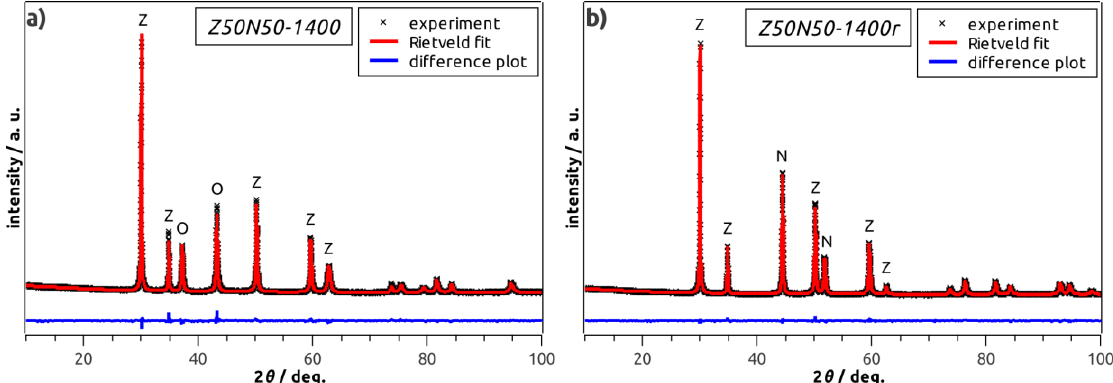
Figure 4. Powder XRD patterns of selected Z50N50-1400 specimens before ( a ) , and after the hydrogen treatment ( b ). The letters Z, N, O correspond to the main reflections of YSZ, Ni and NiO, respectively.